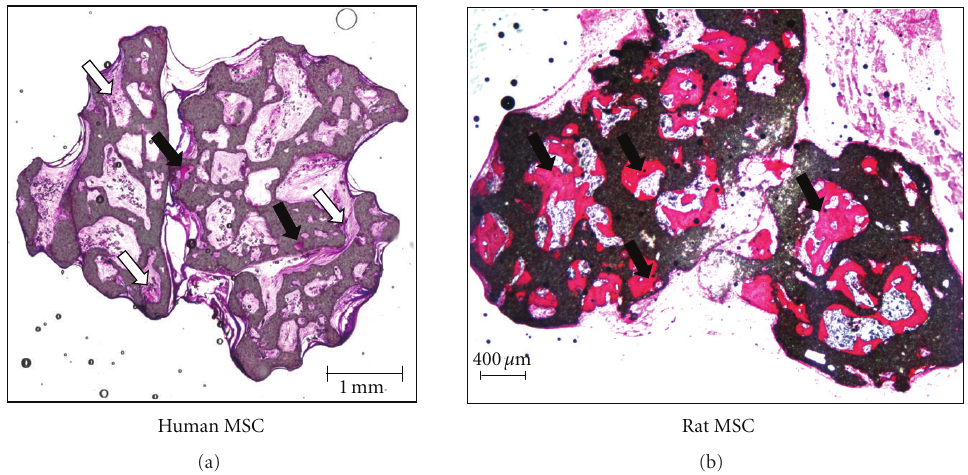
Figure 6: Representative section of sca ff old seeded with human bone marrow compared to that seeded with rat bone marrow. Calcium phosphate ceramic sca ff olds were seeded with equal number of cells derived from either human or rat bone marrow and implanted subcutaneously in nude mice for 6 weeks. Almost all the pores of the sca ff old seeded with rat cells are filled with newly formed bone while the pores of the sca ff old seeded with human cells have only one pore with a small amount of bone while the rest of the pores are filled with fibrous tissue. The sections are stained with basic fuschin and methylene blue. The newly formed bone is stained red with basic fuschin (black arrows) while the remaining fibrous tissue is stained pink (white arrows). The black areas represent the sca ff